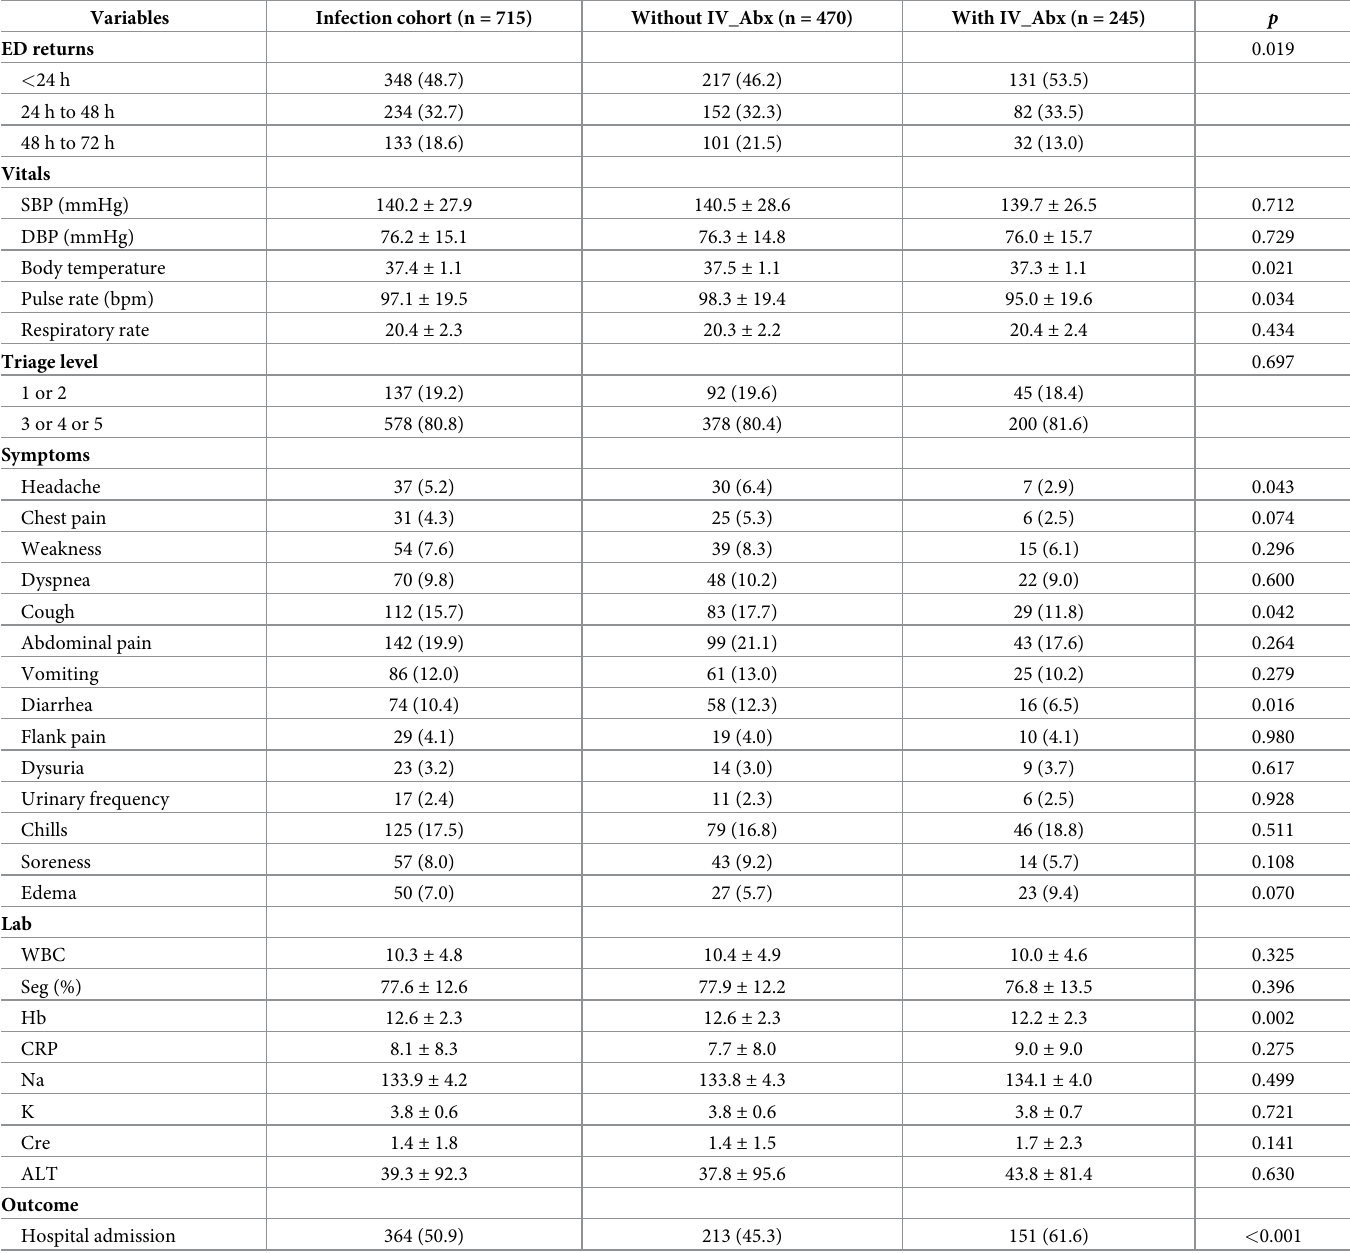
COPD = chronic obstructive pulmonary disease; CRP = C-reactive protein; DBP = diastolic blood pressure; Hb = hemoglobin; IV_Abx = intravenous antibiotics; SBP = systolic blood pressure; WBC = white blood